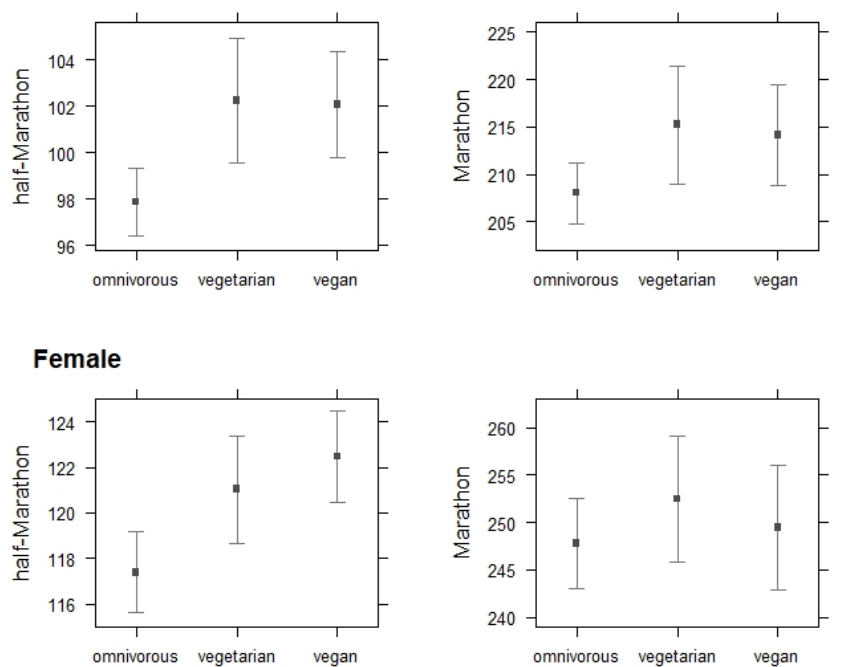
Figure 2. Effect plots with 95%-CI to show the differences between dietary subgroups in half- marathon and marathon performance in male and female recreational